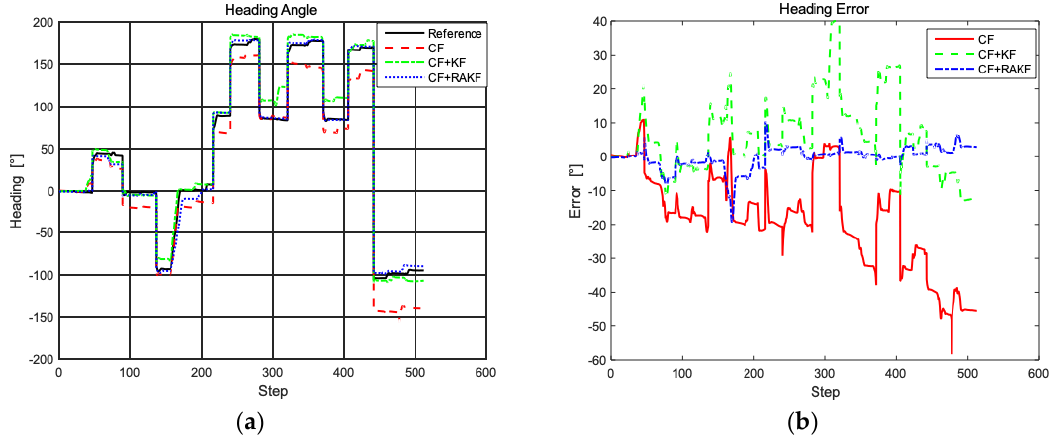
Figure 9. Heading analysis in different filtering strategies. ( a ) Comparison of heading; ( b ) Heading error comparison.